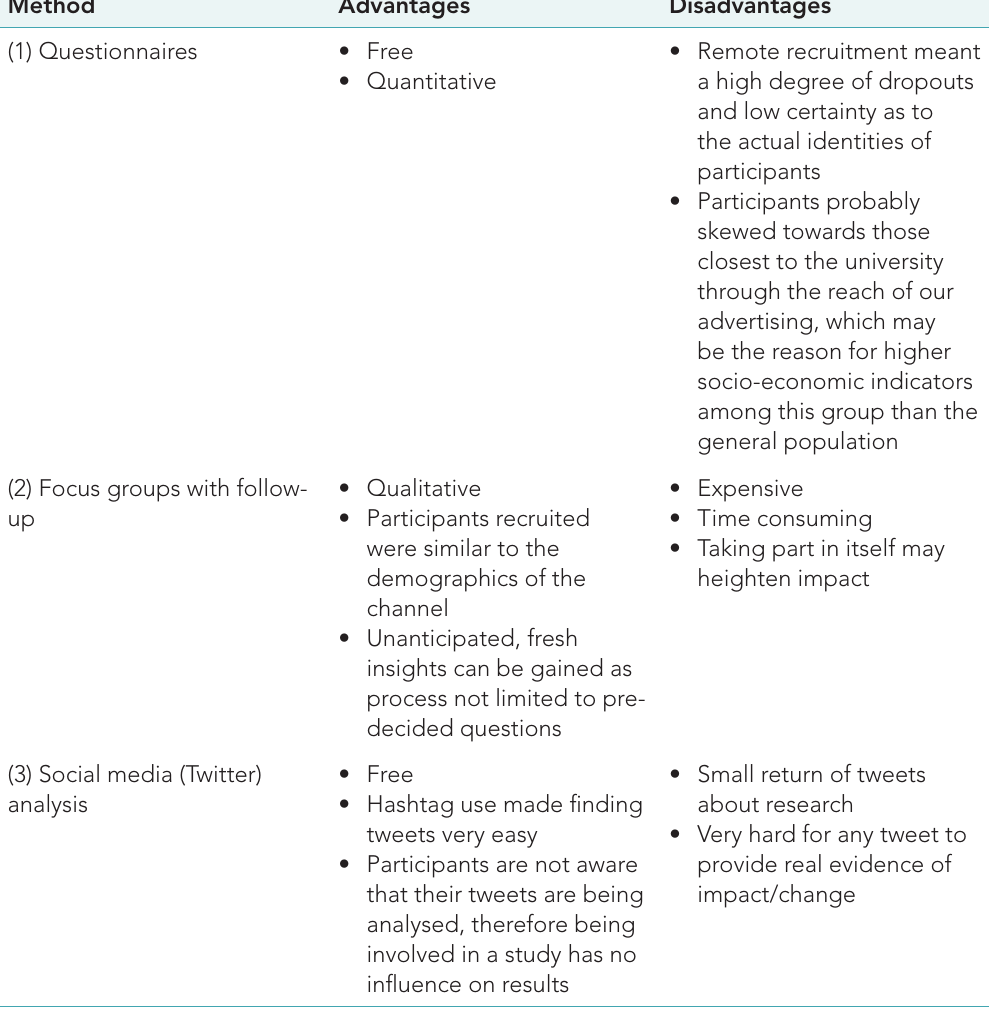
Table 1: Advantages and disadvantages of the approaches